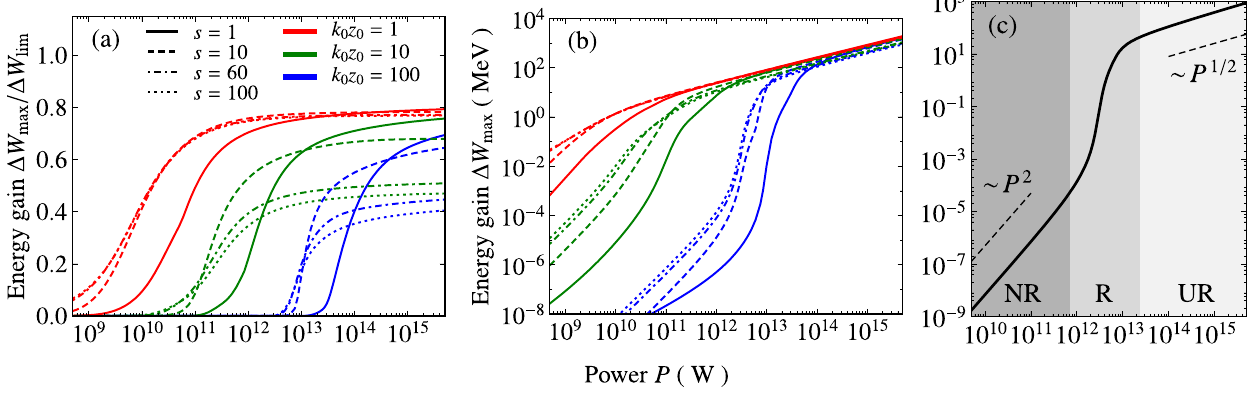
Figure 6. Maximum ( a ) normalized and ( b ) absolute final energy gain of an electron initially at rest on the optical axis versus the laser pulse power for different combinations of k s ; ( c ) A close-up on the case k non-relativistic (NR) to the relativistic (R) and ultra-relativistic (UR) dynamical regimes discussed in Table